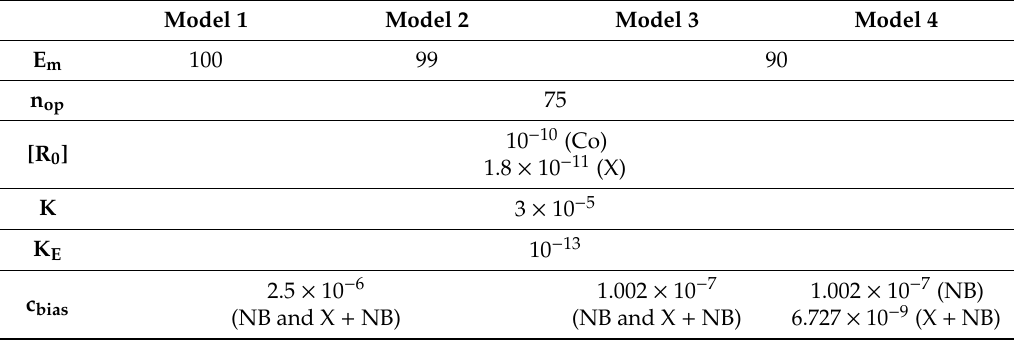
Table 3. Parameters of the operational model of agonism defining four in silico